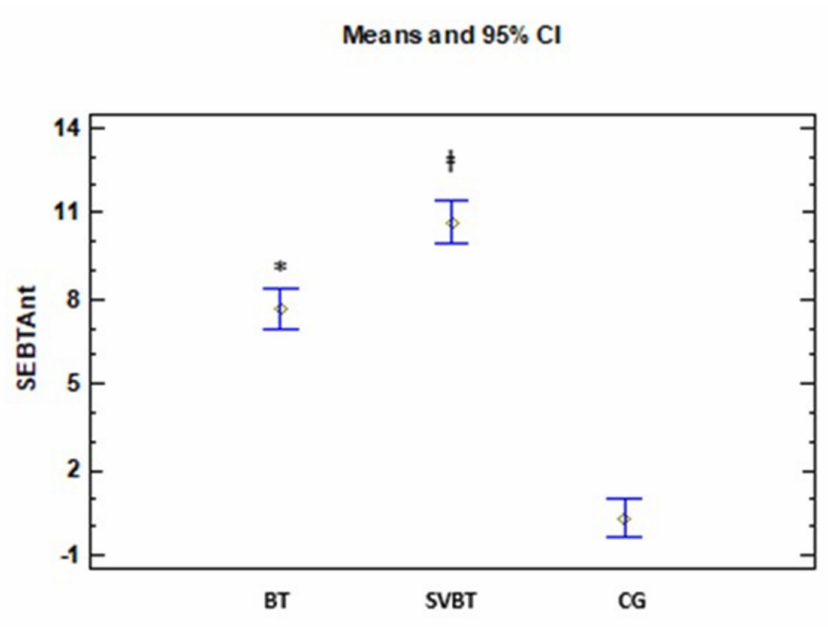
Figure 3. Anterior SEBT change scores after the intervention. Anterior reach distance of the star excursion balance test (SVBT any). ‡ (SVBT > BT) * (BT >